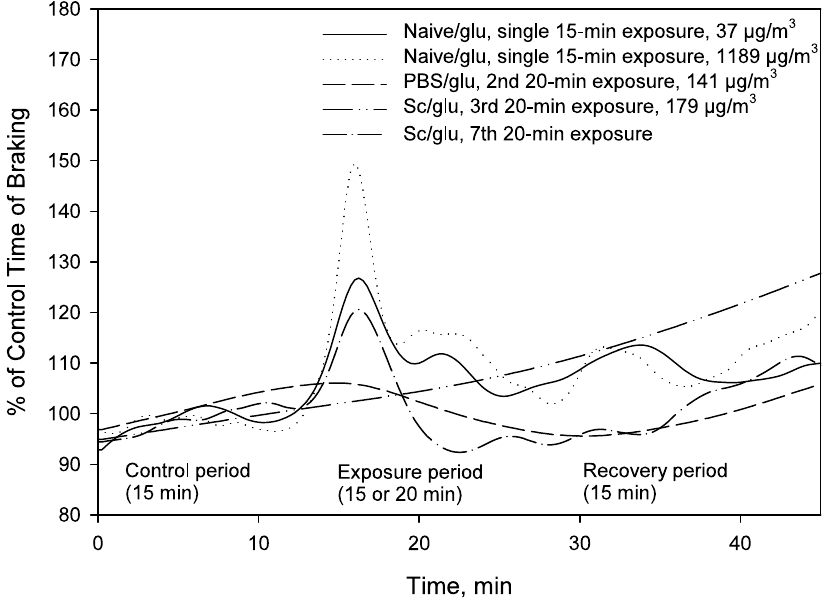
FIG. 1. Average time (cid:1) / response plots of four mice of time of braking (TB) during inhalation exposure to b -glucan aerosol. Mouse group (immunization/inhalation exposure), the order of exposure, and exposure concentration are indicated. The naı¨ve/glu mice were male OF1 mice, and the rest of the groups consisted of female BALB/c mice. The average TB value calculated from all the breaths collected during the 15 min control period was set equal to 100%, and all the data collected during the whole experiment (in each 15 sec collection period) was then presented as a percentage of this value. Plots from the low and high single-exposure concentrations and from repeated exposures experiments are included. During the control and recovery periods, filtered air was fed into the breathing zone of the